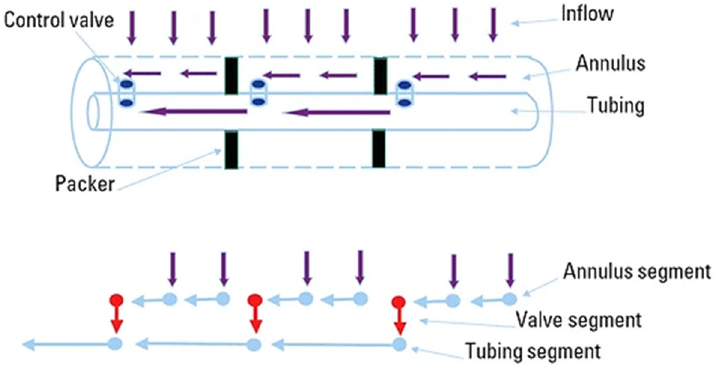
Figure 5. Illustration of the MSW model [20].